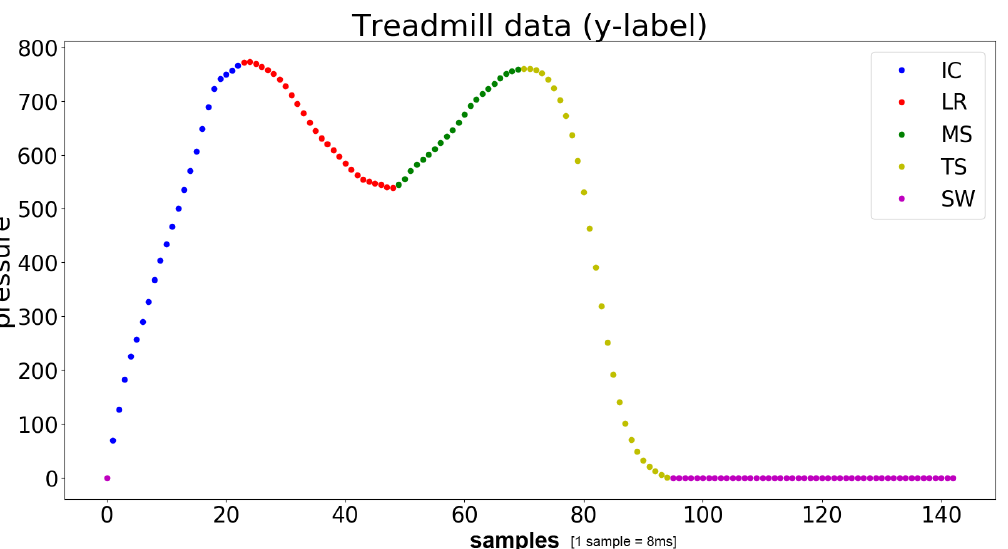
Figure 1. The pressure curve of one step, measured by the treadmill. The different colors indicate the gait phases used in this work. On the x-axis the time is given in frames (1 frame = 8 ms). The y-axis indicates the absolute pressure accumulated on the